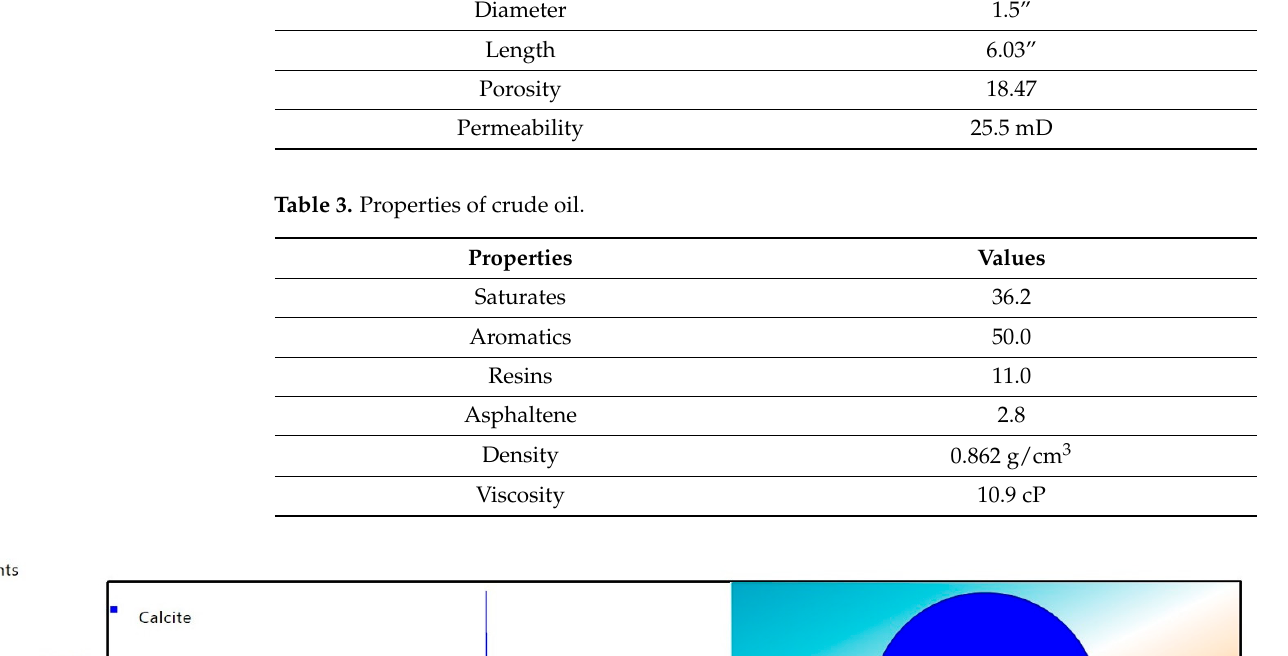
Table 2. Properties of carbonate core samples.